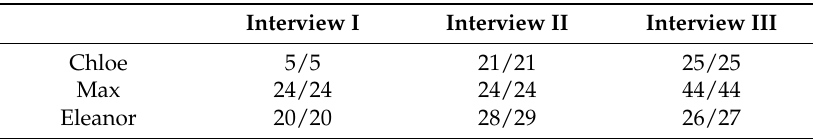
Table 3. Object clitic suppliance in obligatory